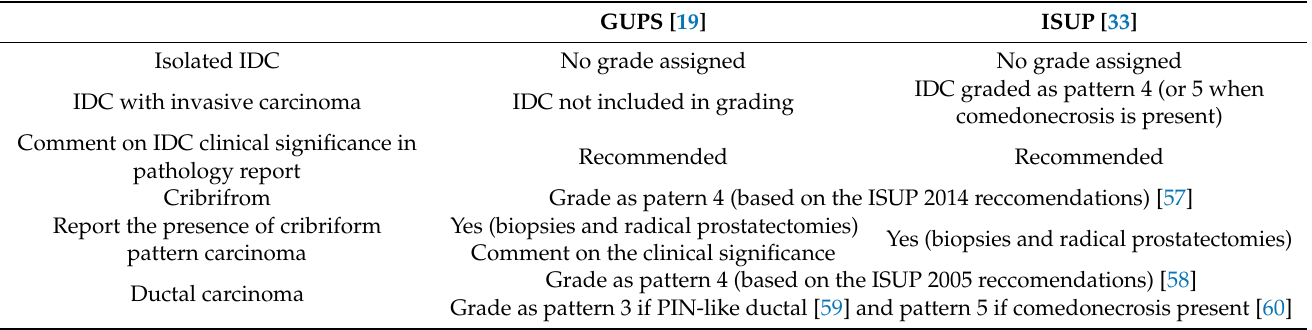
Table 3. GUPS and ISUP guidelines regarding the grading of cribriform-patterned